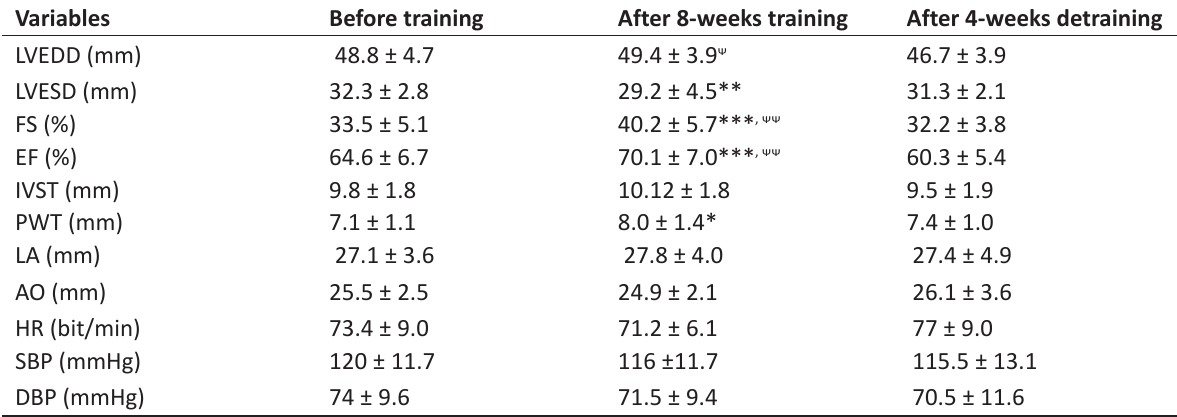
Table 1 . Absolute values of left ventricle structural and functional features of the subjects (Means ± SDs)